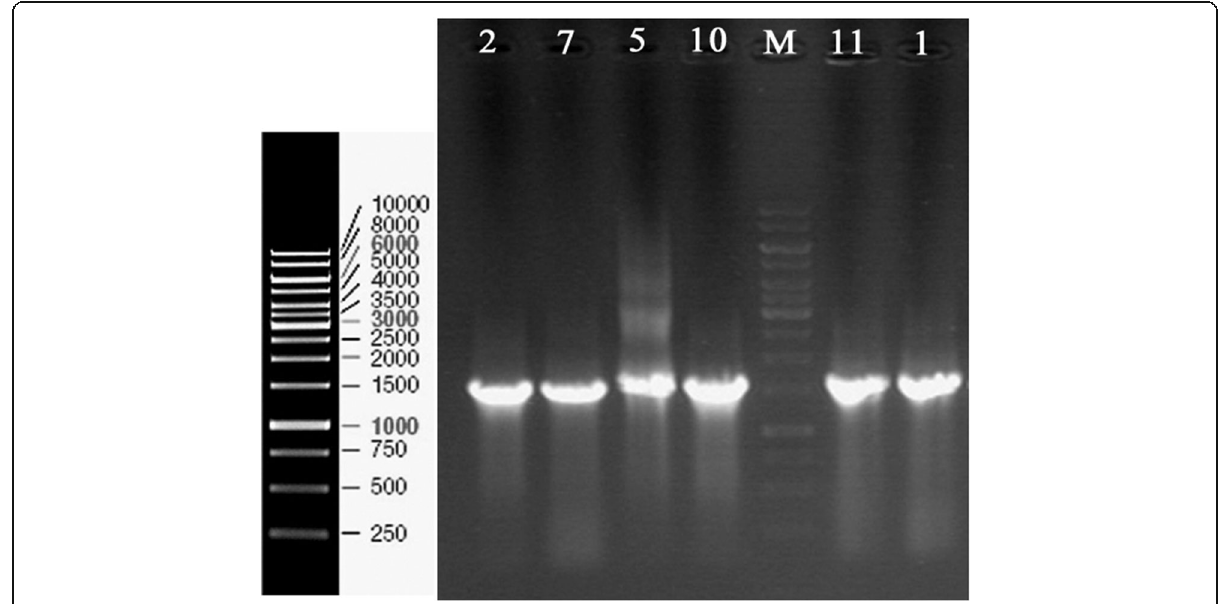
Fig. 2 Electrophoresis pattern of PCR products of 16S rDNA region for bacterial isolates: 1, 2, 5, 7, 10, and 11: number of bacterial isolates. M: GeneRuler TM 1 kb DNA Ladder,